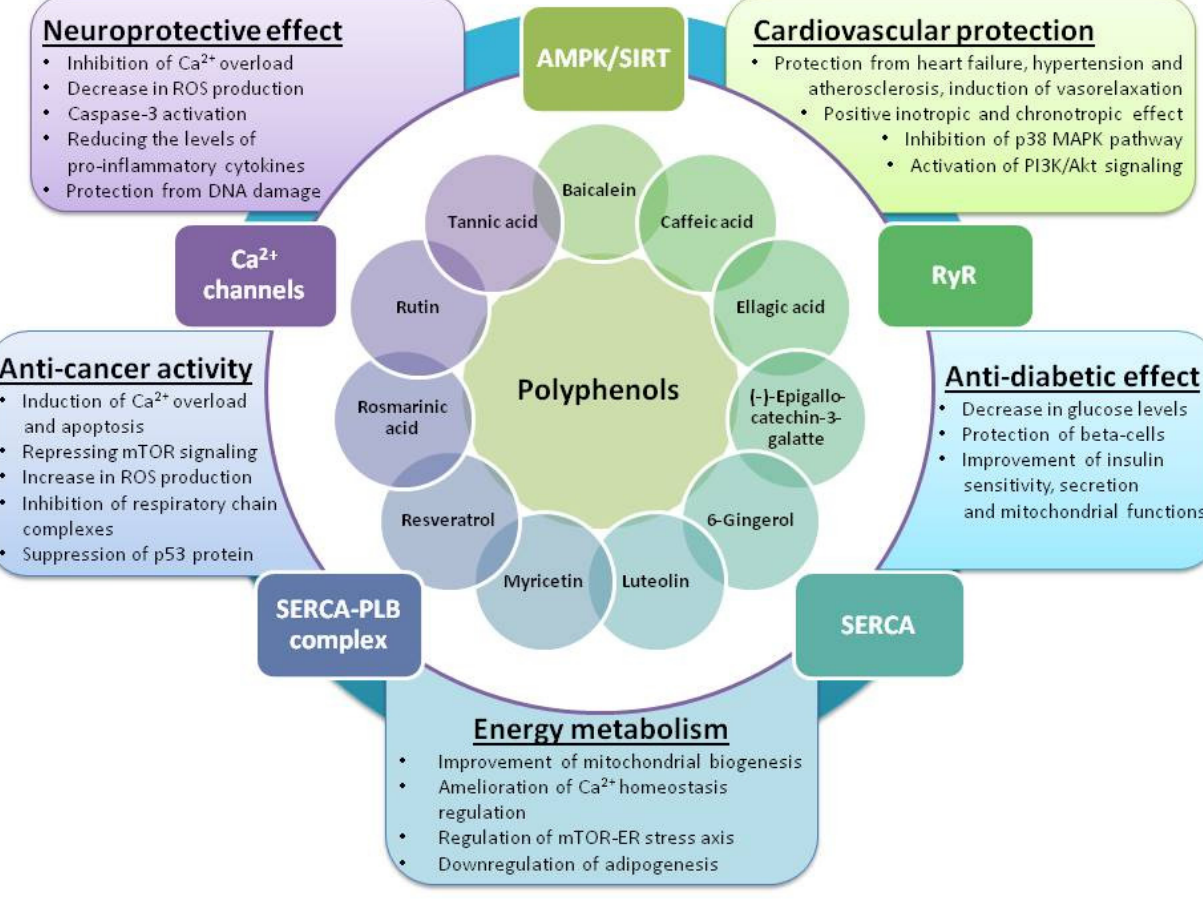
Figure 1. Ca 2+ -dependent protective effects of polyphenols linked to ER stress-related diseases.